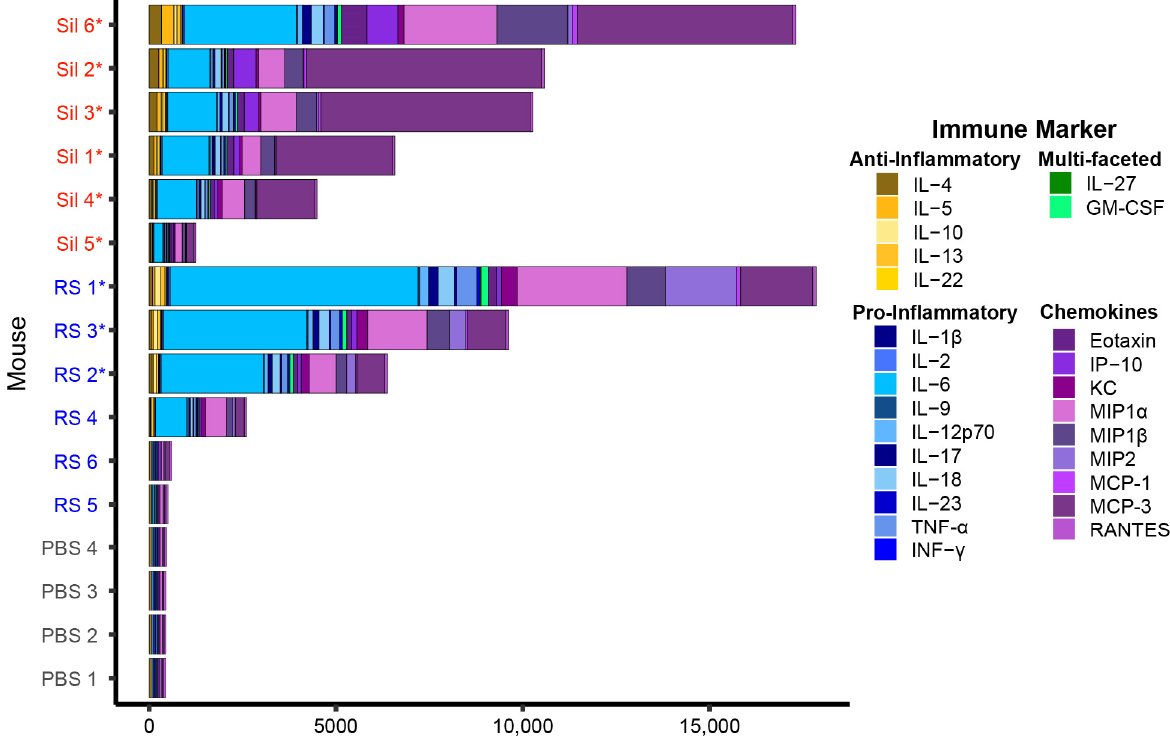
Figure 1. There is a gradient of total cytokine concentrations in the BALF of Coccidioides -inoculated mice. A total of 26 cytokines are shown for individual mice inoculated with C. immitis strain RS (blue) and C. posadasii strain Silveira (Sil; red), or sham-inoculated with PBS (gray). Mice with disseminated disease are indicated with an asterisk (fungal counts in the spleen and brain are provided in Supplementary Table S2). Immune markers are color-coded by type, and should be read from left to right in the bar graph in order to match them with their labels in the legend, listed from top to bottom. Cytokine production was dominated by pro-inflammatory cytokines (blue) and chemokines (purple), while anti-inflammatory (yellow) and multifaceted (green) cytokines were produced at low levels.